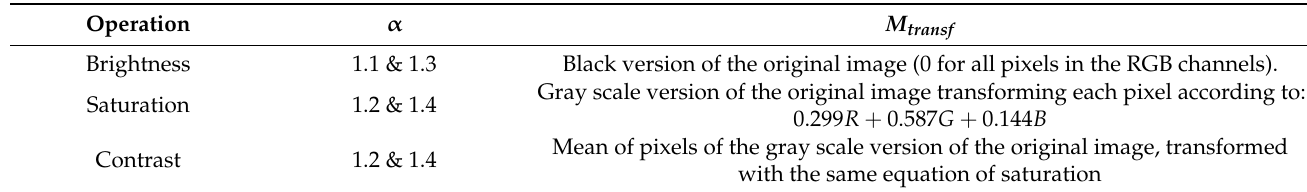
Table 1. Data augmentation operations of brightness, saturation, and contrast.